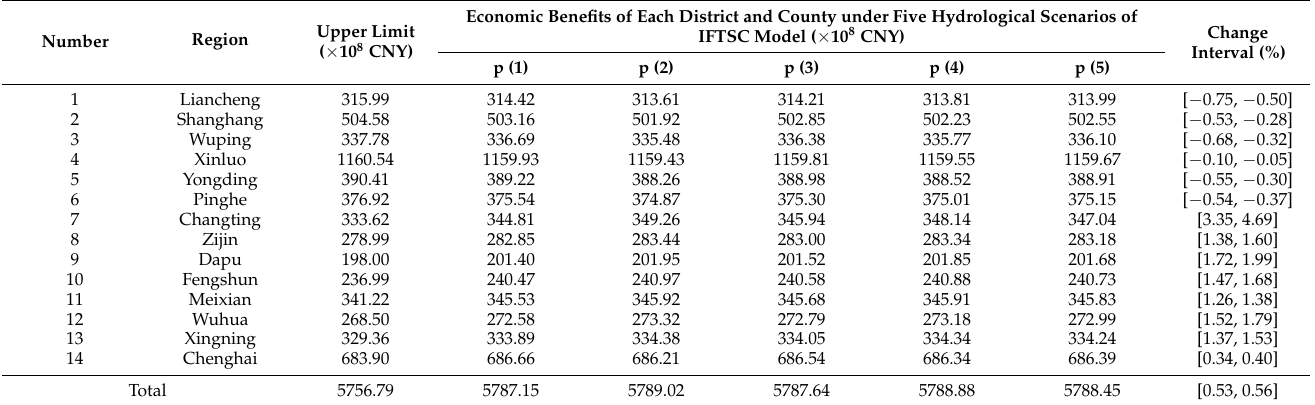
Table 4. Economic benefits of each district and county under five hydrological scenarios simulated by IFTSC (upper limit).